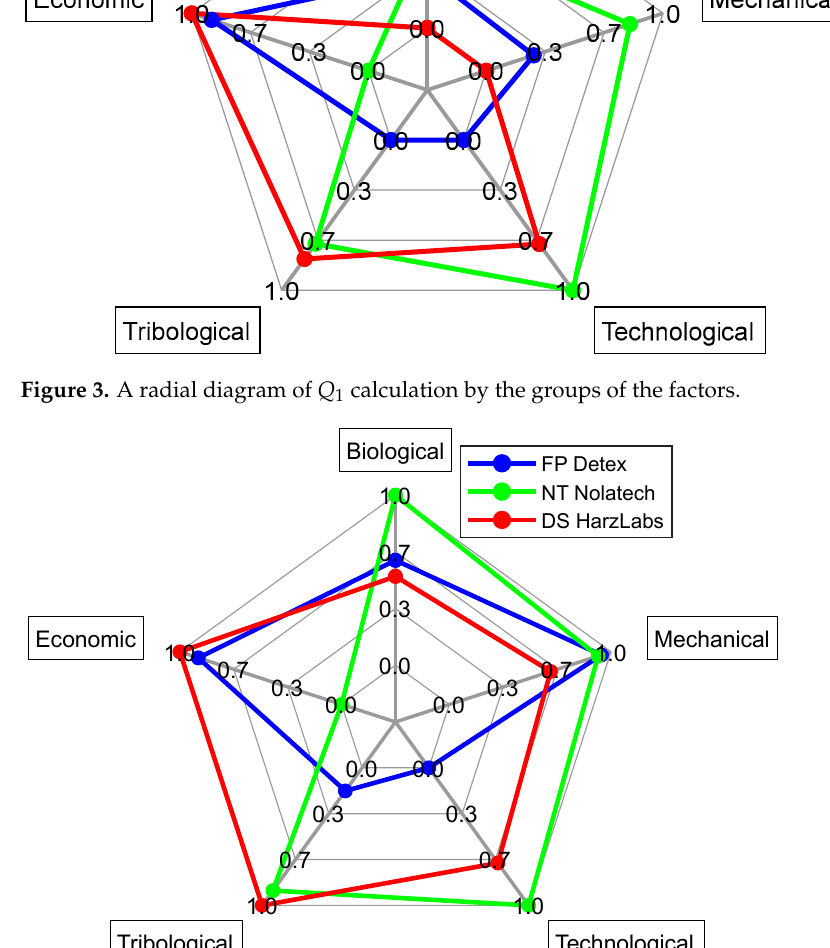
Figure 4. A radial diagram of Q 2 calculation by the groups of the factors.